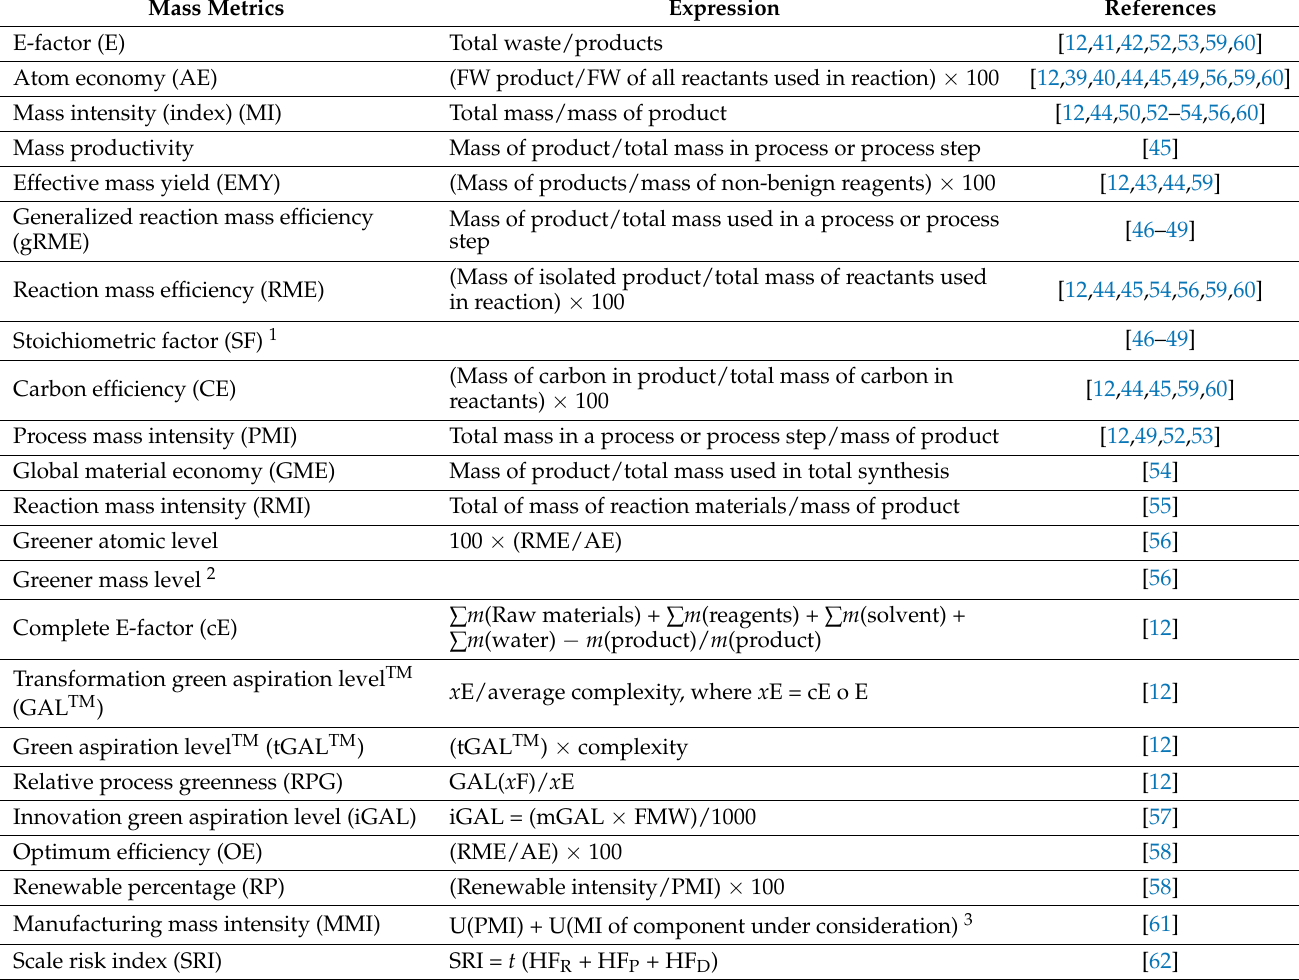
Table 3. Mass metrics to evaluate green